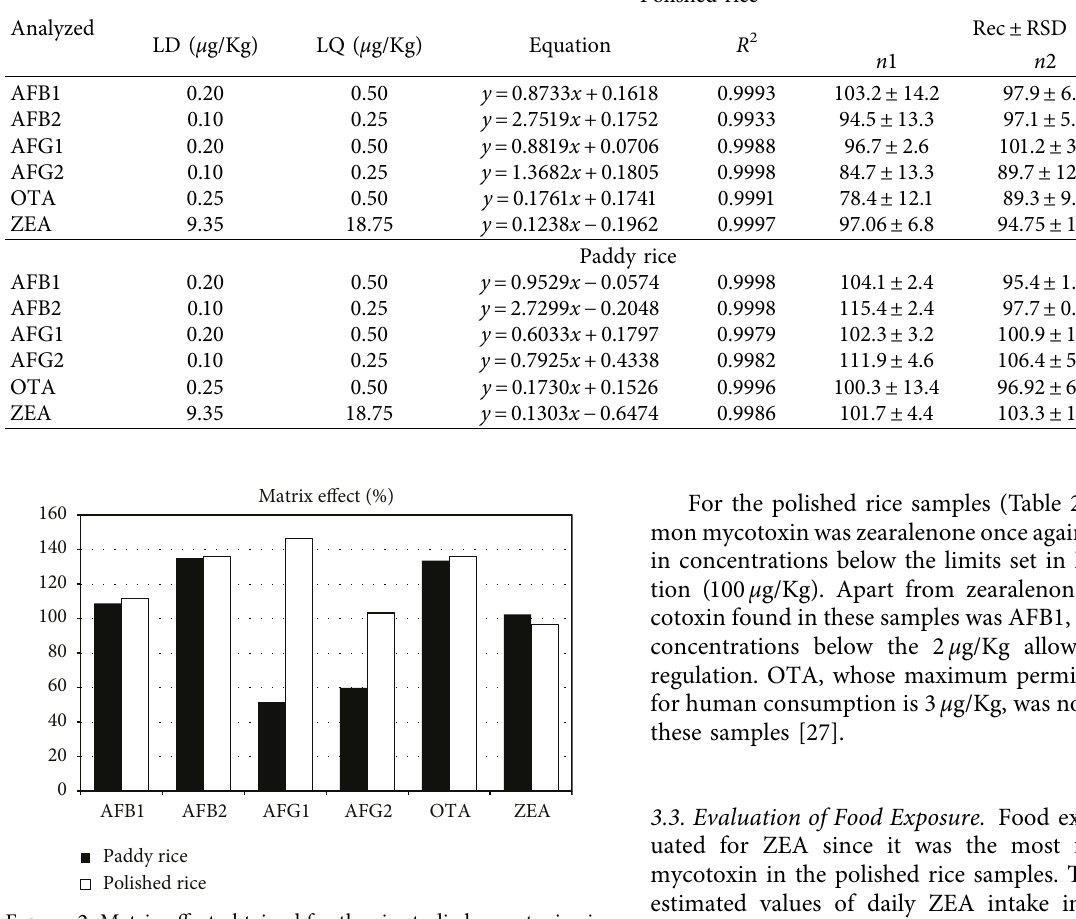
Figure 2: Matrix effect obtained for the six studied mycotoxins in polished rice and paddy rice.